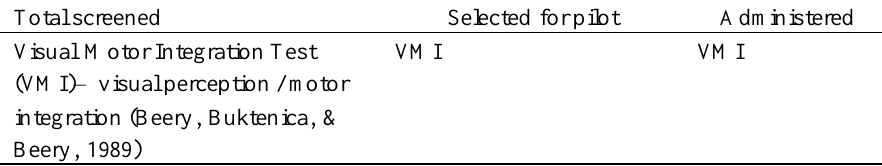
Total screened Selected for pilot